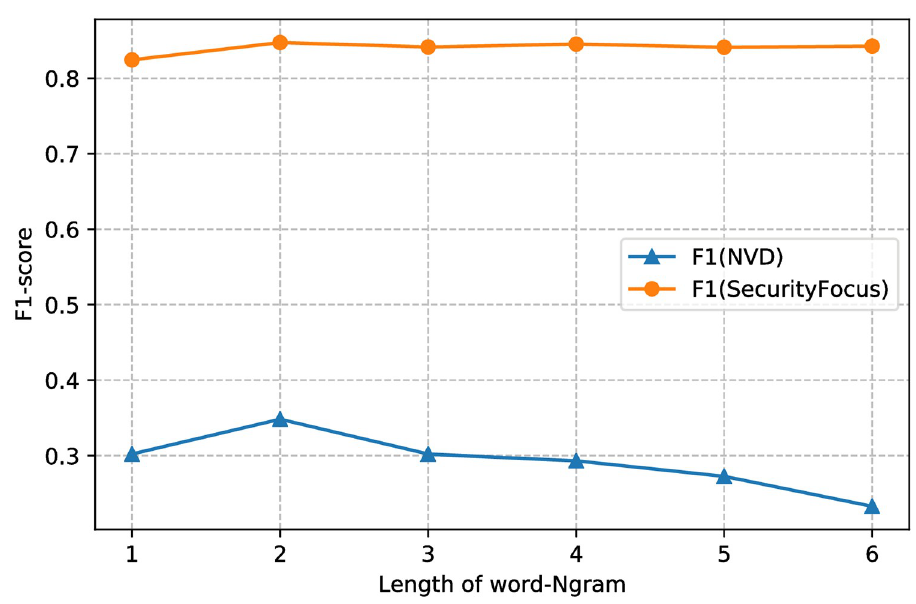
Fig 5. Evaluation by using different length of word N-gram.